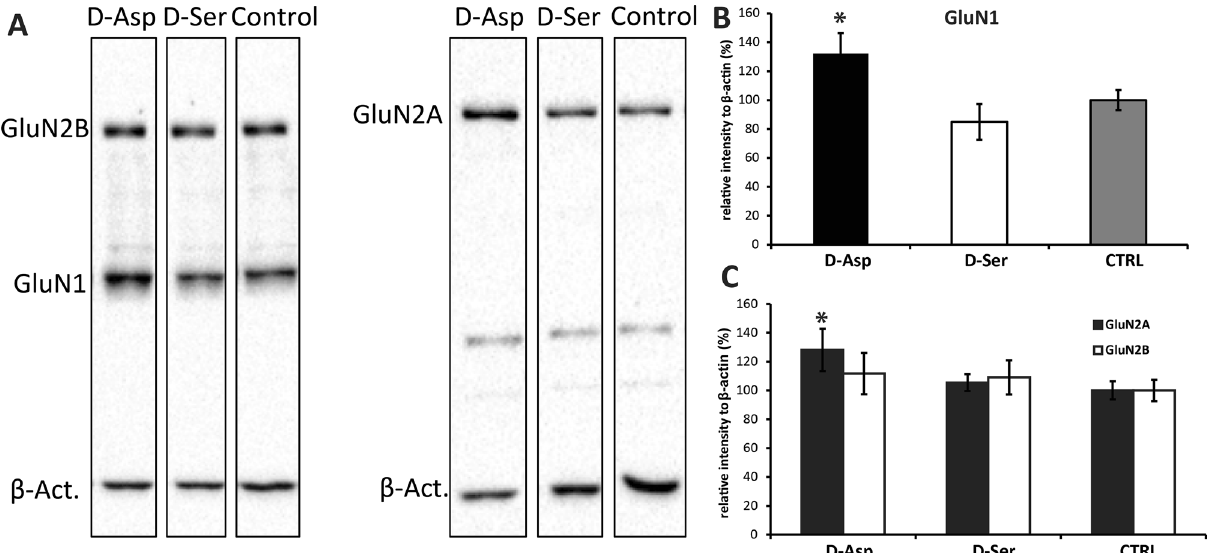
Figure 4. ( A ) Representative blotting membranes showing the position and density of the subunits of NMDARs in the crude synaptosome fraction of hippocampal tissue extracts. The GluN2A and GluN2B subunits were run on different membranes for technical reasons. The bands corresponding to respective GluN subunits and to beta-actin were developed using different exposure times prior to scanning. Region of the blot containing GluN2B subunits has been cut off and processed separately. For full length blots see supplementary Figures S1 and S2. ( B ) The expression of GluN1 subunit was significantly elevated in the hippocampus of d-Asp consuming mice as compared to controls (*t = 2.05, P = 0.048). ( C ) d-Asp mice also showed greater expression of the GluN2A subunit as compared to controls (*t = 2.32, P = 0.026), but there was no significant difference in the expression of